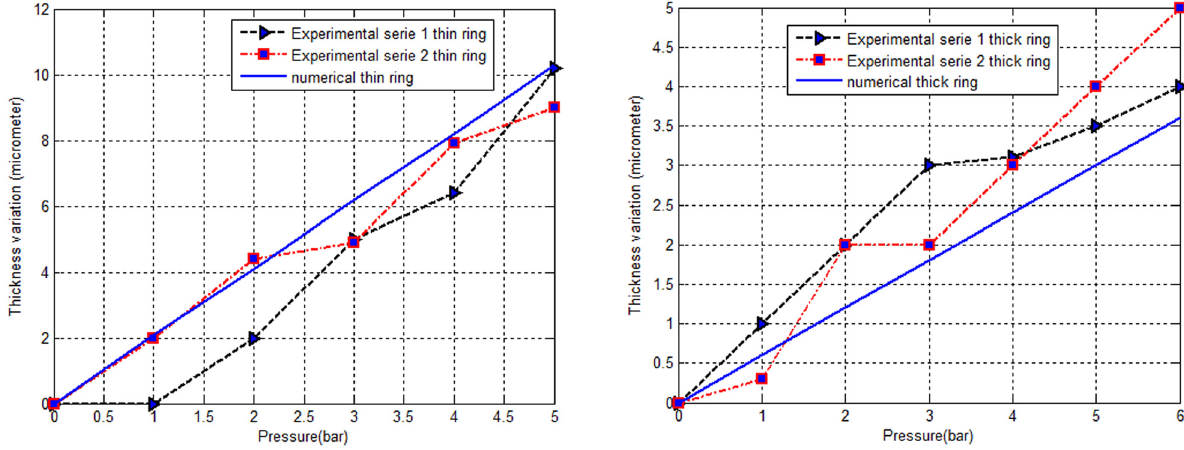
Figure 8: Evolution of thickness variation.